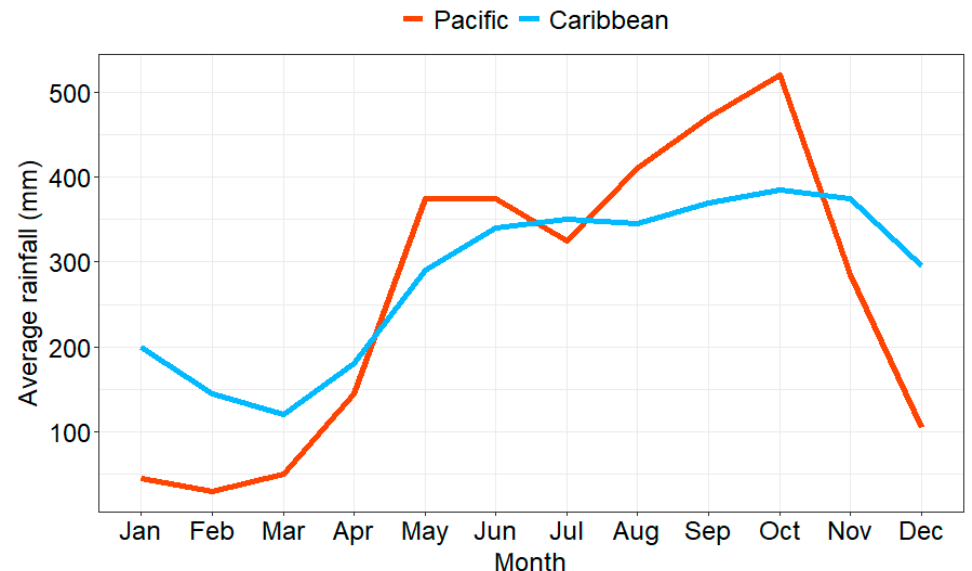
Figure 2. Costa Rican Pacific and Caribbean basins rainfall trends [46].